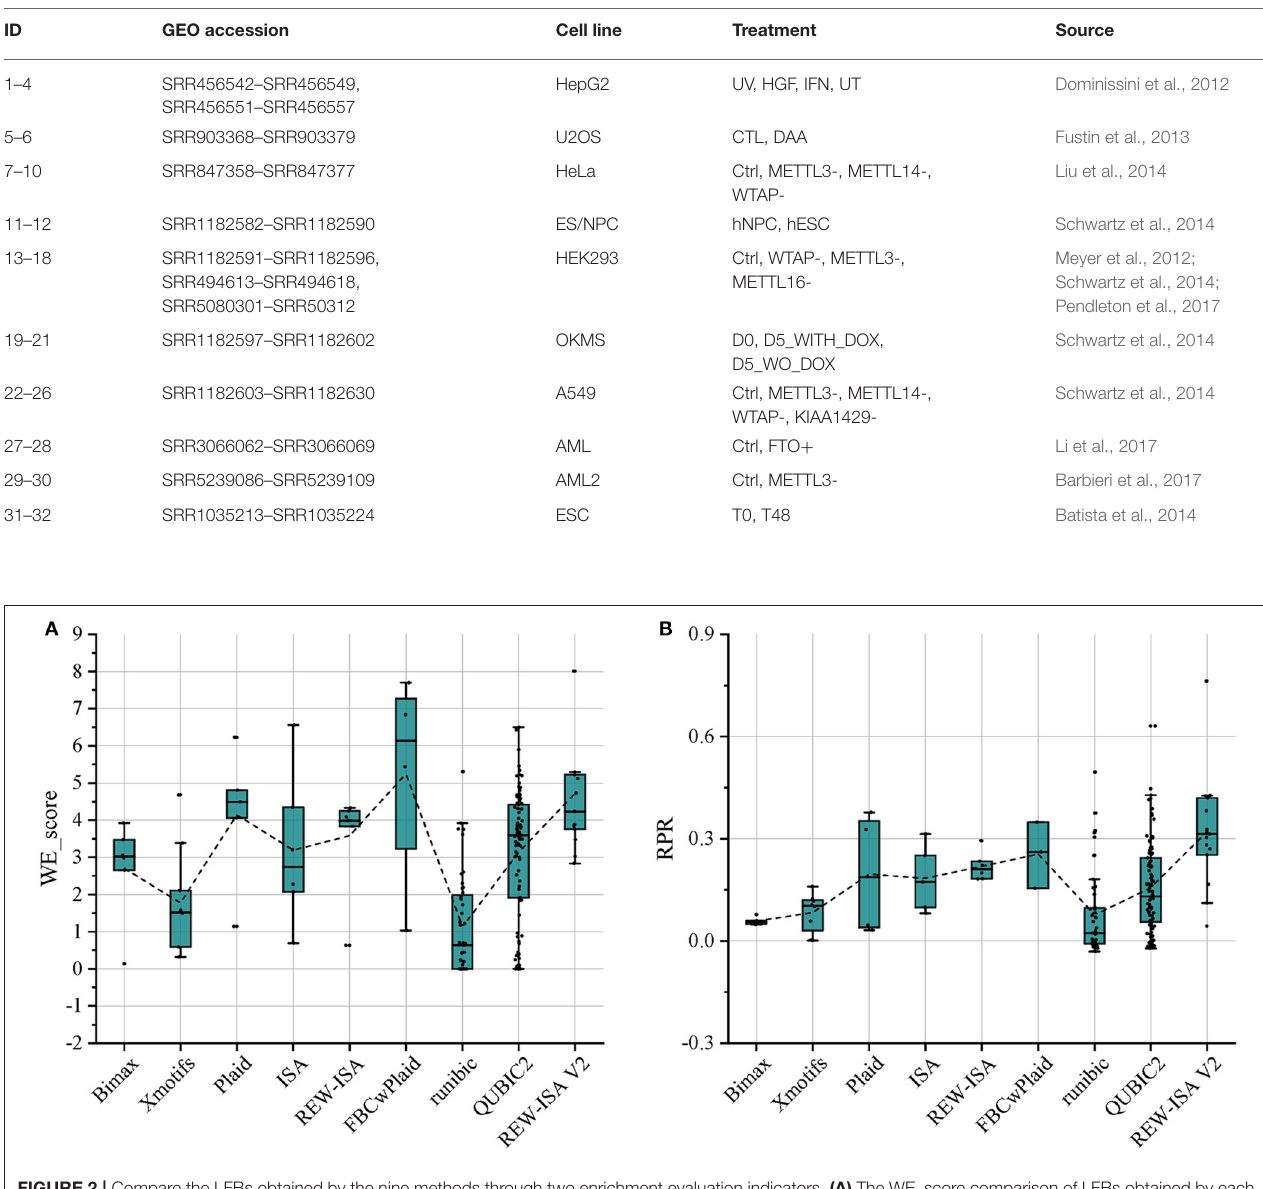
FIGURE 2 | Compare the LFBs obtained by the nine methods through two enrichment evaluation indicators. (A) The WE_score comparison of LFBs obtained by each method. (B) The RPR comparison of LFBs obtained by each method. The connecting line between the boxes is the mean connecting